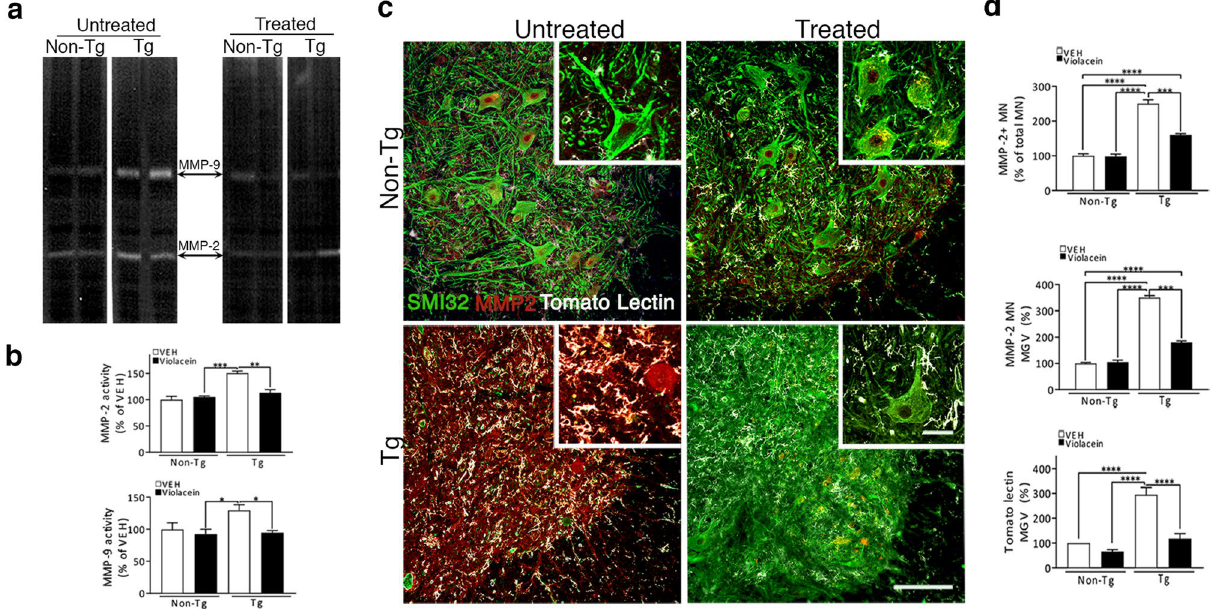
Figure 8. Low MMP-2 activity and immunoreactivity in lumbar spinal cord from Tg-treated rats. ( a ) Zymograms from spinal cord homogenates from all experimental conditions evidenced violacein effects decreasing MMP-2 and -9 signals. ( b ) Quantitative analysis showed increased MMP-2 (p = 0.0005) and MMP-9 (p = 0.0292) activities in Tg-untreated compared with Non-Tg homogenates, but also in Tg-untreated versus Tg-treated samples (p = 0.0016 and p = 0.0115, for MMP-2 and MMP-9, respectively). No differences were found in MMP-2 and MMP-9 activity between Tg-treated and Non-Tg samples (p = 0.7945 and p = 0.9987, respectively). ( c ) Representative confocal Z-stack images of immunofluorescences against MMP-2 (red), SMI32 (green) and Tomato lectin (white) on transverse sections of lumbar spinal cords from each experimental condition. In Non-Tg sections appeared many SMI32 positive motor neurons with typical morphology and with nuclear and perinuclear MMP-2 signal. Higher MMP-2 immunoreactivity was seen in Tg-untreated section mostly in motor neurons with low SMI32 expression and also in the spinal cord parenchyma. This was accompanied with high microglial reactivity and generally decreased SMI32 immunoreactivity. The Tg-treated condition exhibited less MMP-2 positive motor neurons, more SMI32 positive motor neurons with the typical signal 45 as well as lower microglial reactivity when compared with Tg-untreated condition. Insets in each image show motor neurons with representative SMI32 and MMP-2 signals found in each condition and microglia with different degrees of reactivity. Calibration: 30 µm (images) and 15 µm (insets). ( d ) Quantitation of the immunoreactivity signals indicated a decreased percentage of MMP-2 positive motor neurons related to total SMI32 positive motor neurons as well as significant decreased MMP-2 positive motor neurons when comparing Tg-treated versus Tg-untreated rats (p = 0.0001). A remarkable decrease in microglial reactivity assessed by MGV of Tomato lectin was determined in Tg rats upon violacein treatment (p <